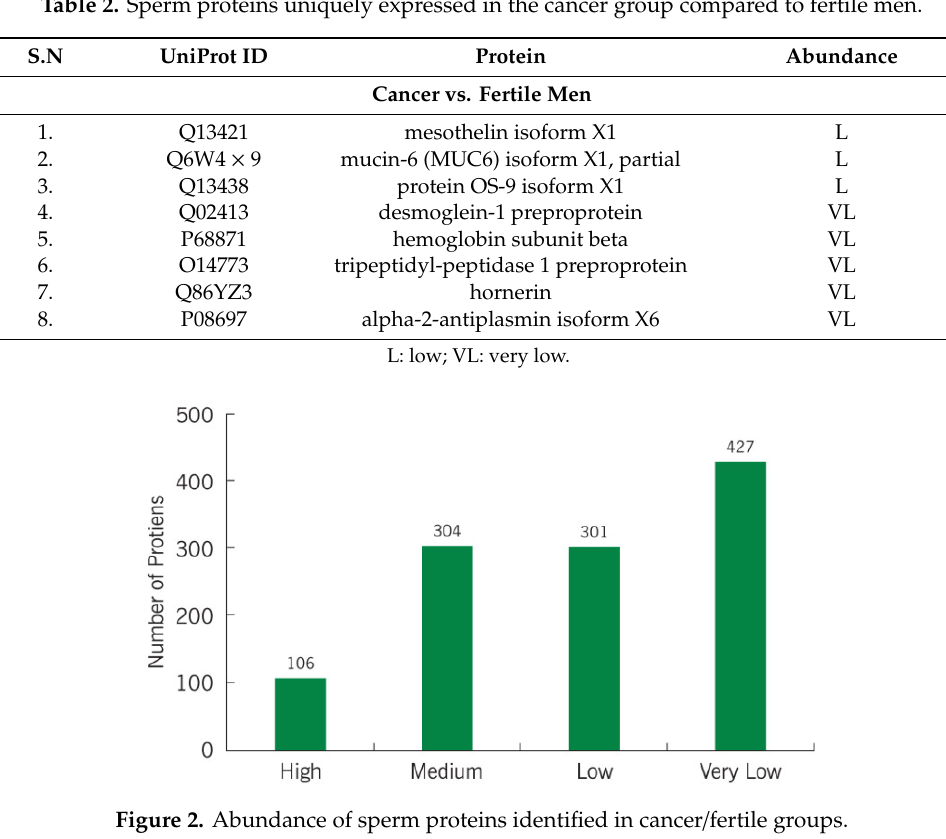
Figure 2. Abundance of sperm proteins identified in cancer/fertile groups.